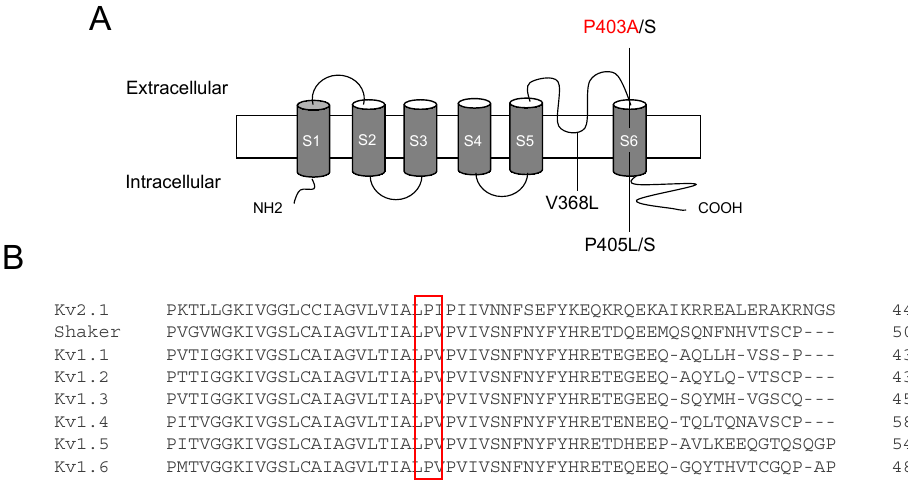
Figure 2. ( A ) Position of identified mutations in the Kv1.1 channel S5–S6 regions, including the P403A variant. ( B ) Amino acid alignment of Kv1 channels.